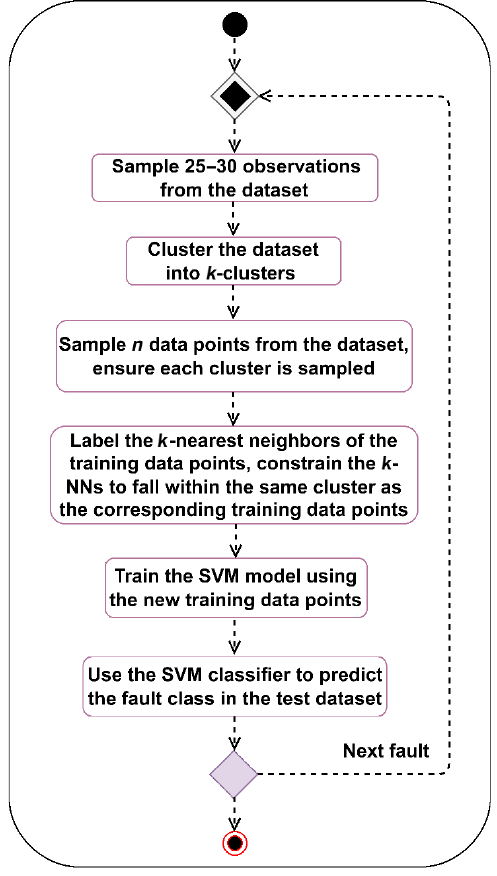
Fig. 4 Method 3 process: Combination of SVM, clustering, and unsupervised learning of the k -NN